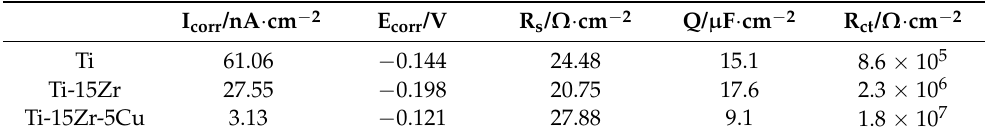
Figure 6. Electrochemical tests results in PBS at 37 °C and pH = 7.2. ( a ) PD curves; ( b , c ) Bode diagram; ( d ) Nyquist curves and equivalent circuit. Table 3. PD curves analysis and equivalent circuit fitting results.